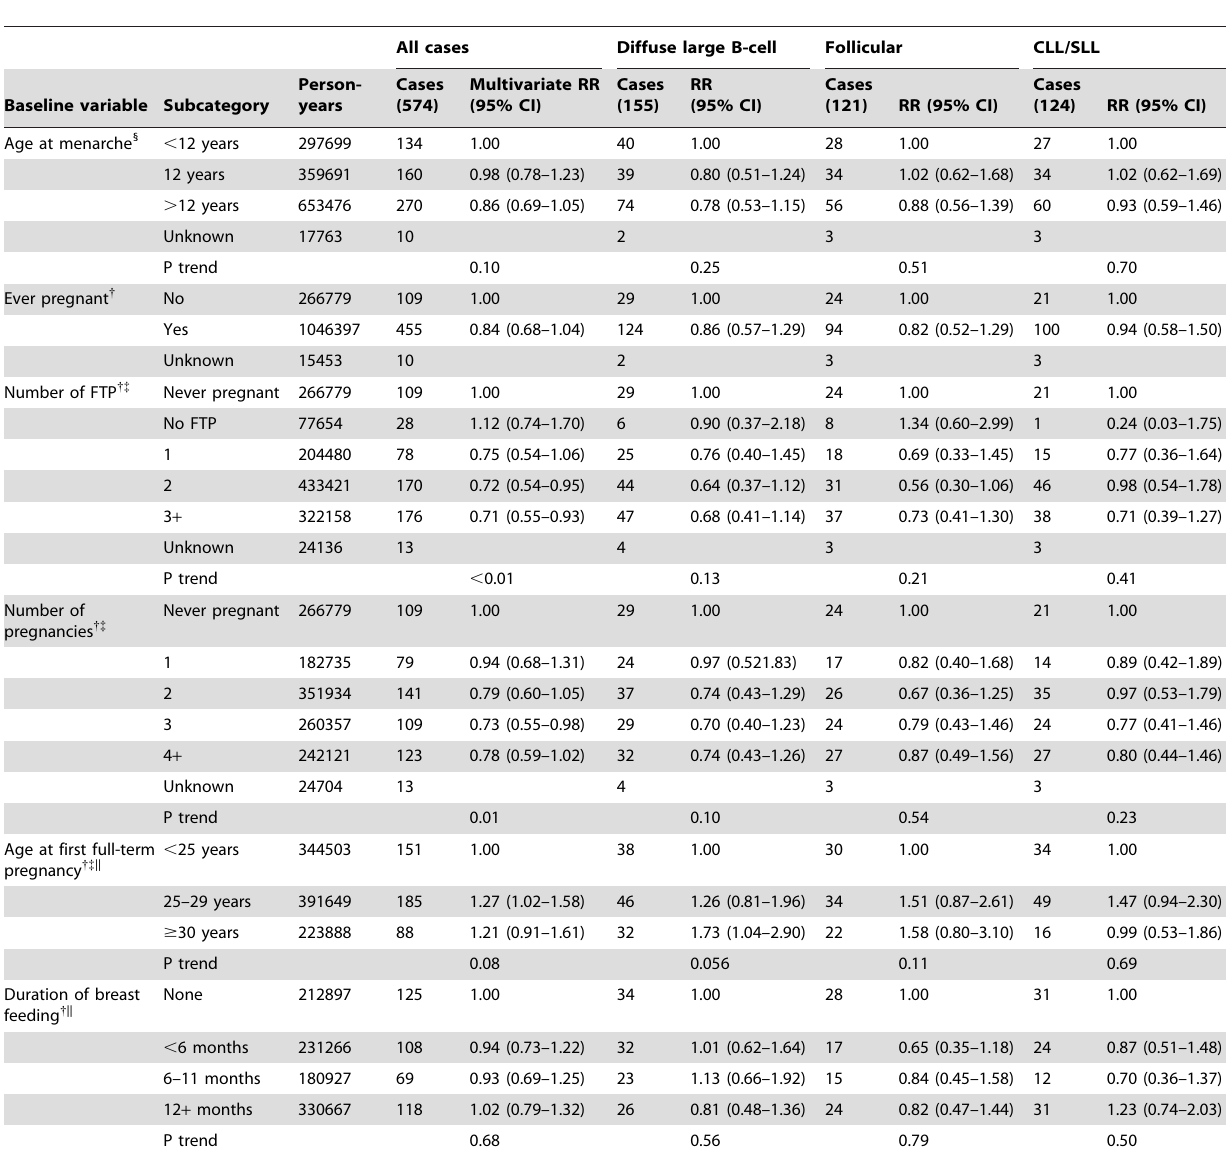
Table 2. Relative risk estimates and 95% confidence intervals for the association between menstrual and reproductive factors and B-cell NHL risk overall and by histologic subtype in the California Teachers